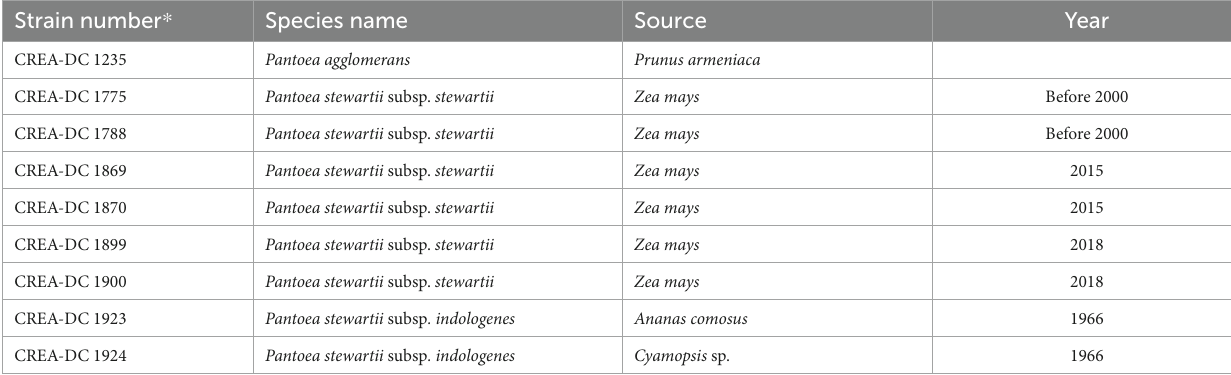
TABLE 2 Isolates sequenced using Oxford Nanopore Technologies (ONT) MinION